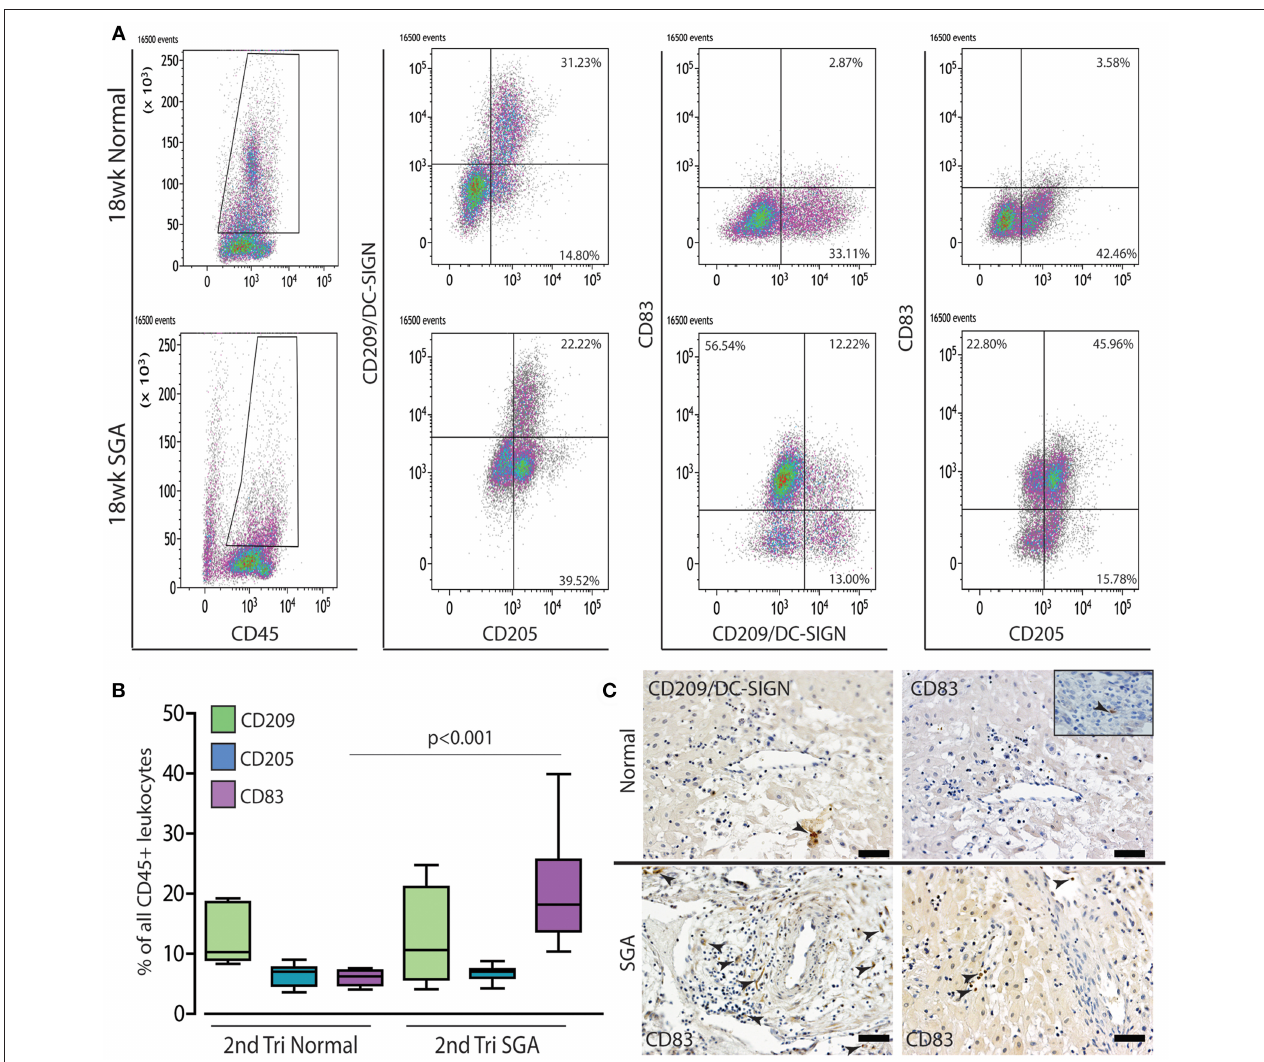
FIGURE 7 | Mature dendritic cells are significantly increased in the 2nd trimester high uterine artery SGA decidua. Representative dot plots of multicolor flow analysis of decidual dendritic cells from an 18-week normal decidua and a decidua from an 18-week high uterine artery PI SGA case. Dendritic differentiation was assessed using three markers CD209/DC-SIGN to mark immature dendritic cells, CD205 to mark intermediate dendritic cells and CD85 to mark mature antigen presenting dendritic cells. Gates were set in the high granular region of the CD45 + gate (A) . Comparison across all samples showed that mature CD83 + dendritic cells are increased to 20% of all CD45 + leukocytes compared to 4% + - in the controls (B) ( p < 0.001, n = 6 per group). Representative immunostained images from one control and 2 high uterine artery PI SGA cases, CD209: immature dendritic cells, CD83: mature antigen presenting dendritic cells ( C , arrows indicate positively stained cells). Inset shows rare CD83 + dendritic cell in control decidua. Scale bar = 20 µ M, 200x